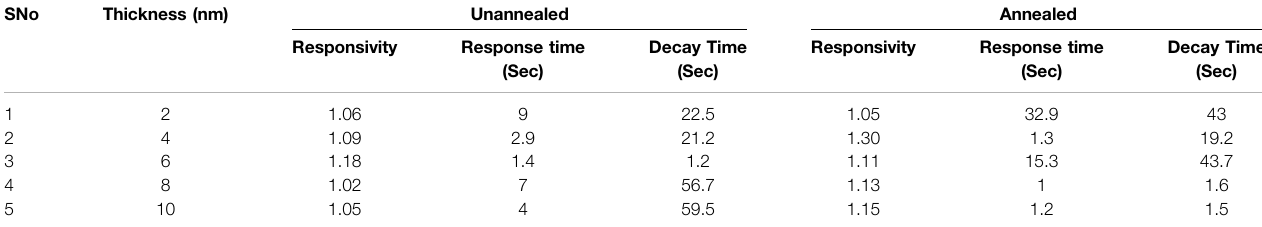
TABLE 3 | UV-sensing responsivity, response time, and decay time of unannealed and annealed Au layers at various thicknesses. SNo